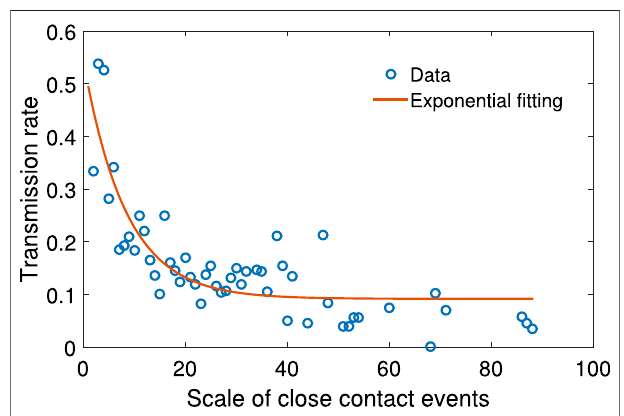
FIGURE 3 | The scatter plot of N vs. the mean of p , together with exponential function fi tting. The relationship between N and p can be fi tted with function p (cid:1) a p exp (− b p N ) + c , where the fi tting parameters are a (cid:1) 0 . 453, b (cid:1) 0 . 121, and c (cid:1) 0 . 092, and the goodness of fi t index is R 2 (cid:1) 0 . 706.